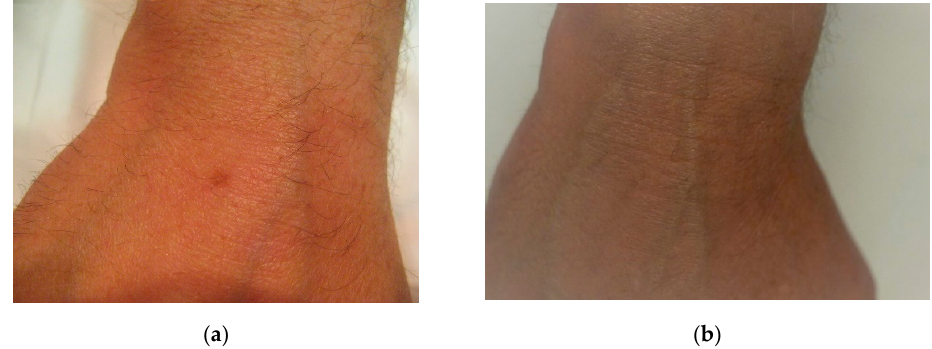
Figure 2. ( a ) Solar lentigines on the hand, before treatment, ( b ) solar lentigines on the hand, after treatment.